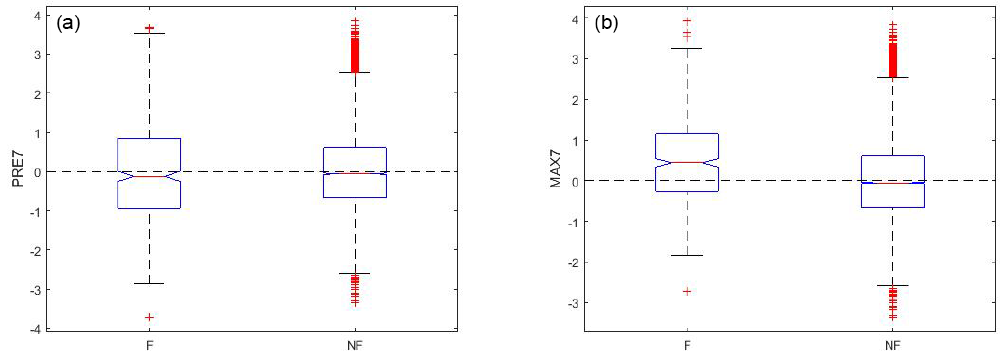
Figure 5. Standardized 7-day preceding precipitation (PRE7; a ) and maximum 7-day precipitation (MAX7; b ) of flood (F; left bars) and no-flood (NF; right bars) events collected over all 501 reported flood